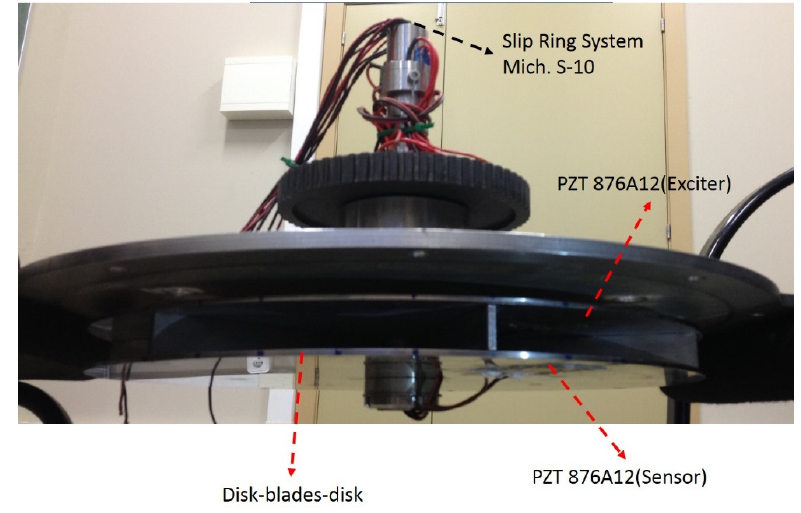
Figure 8. Experimental setup.